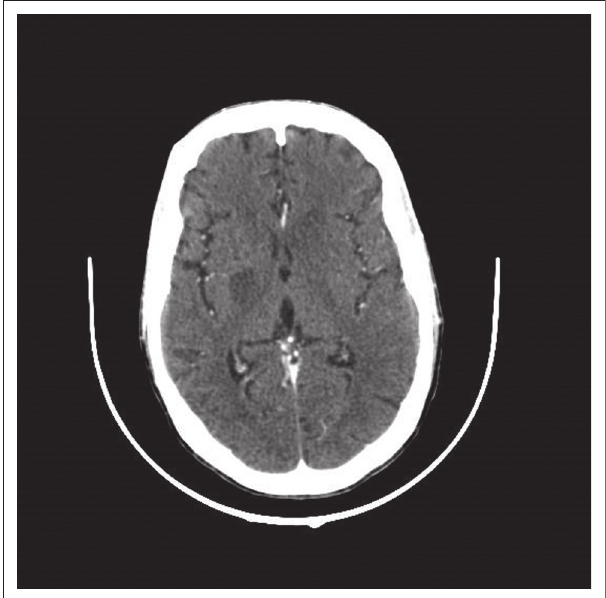
FIGURE 2: Axial contrasted computerised tomography scan with a non- enhancing cryptococcoma in the right basal ganglia.